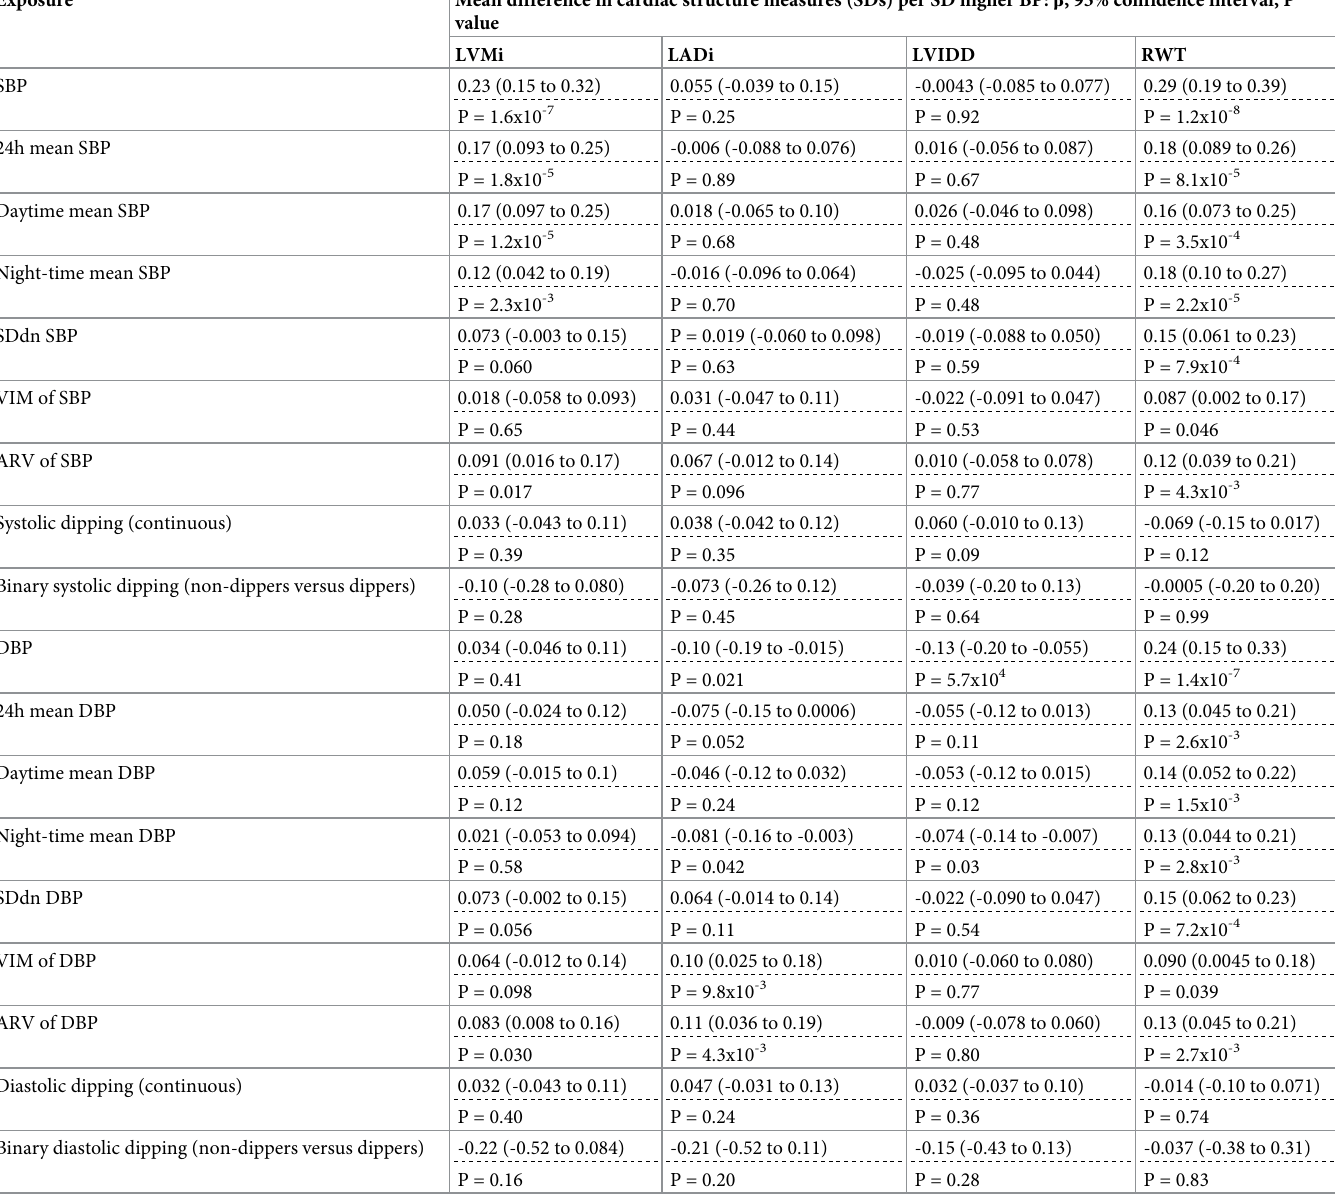
Table 2. Associations of blood pressure measurements with cardiac structure, N = 587.